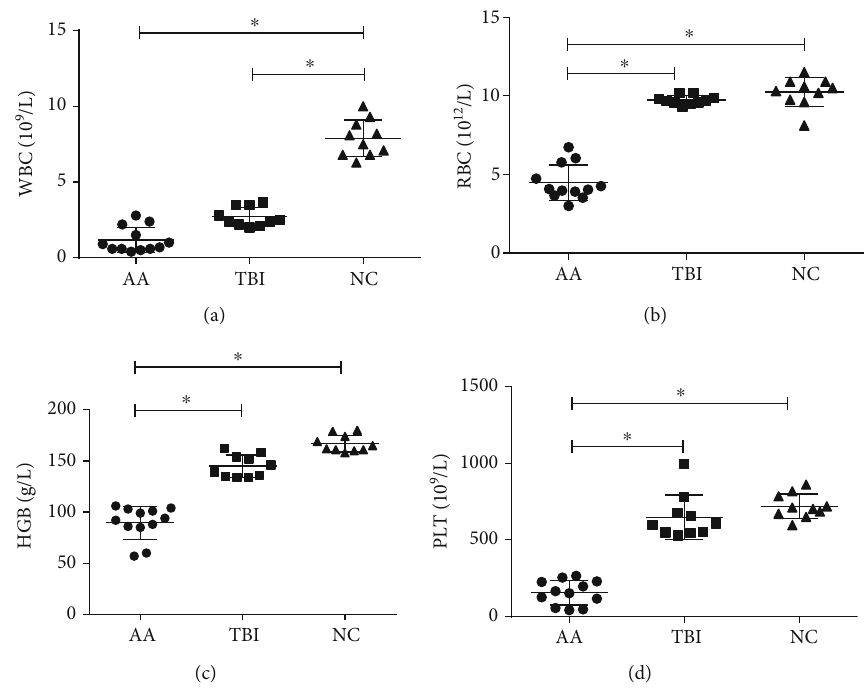
Figure 1: The peripheral blood tests of the AA group CB6F1 mice showed aleukocytosis (a), anemia (b, c), and thrombocytopenia (d) compared with the NC group and TBI group ( ∗ p < 0 : 01 ). AA: aplastic anemia ( n = 12 ); TBI: total body irradiation ( n = 10 ); NC: normal control ( n = 10 ).